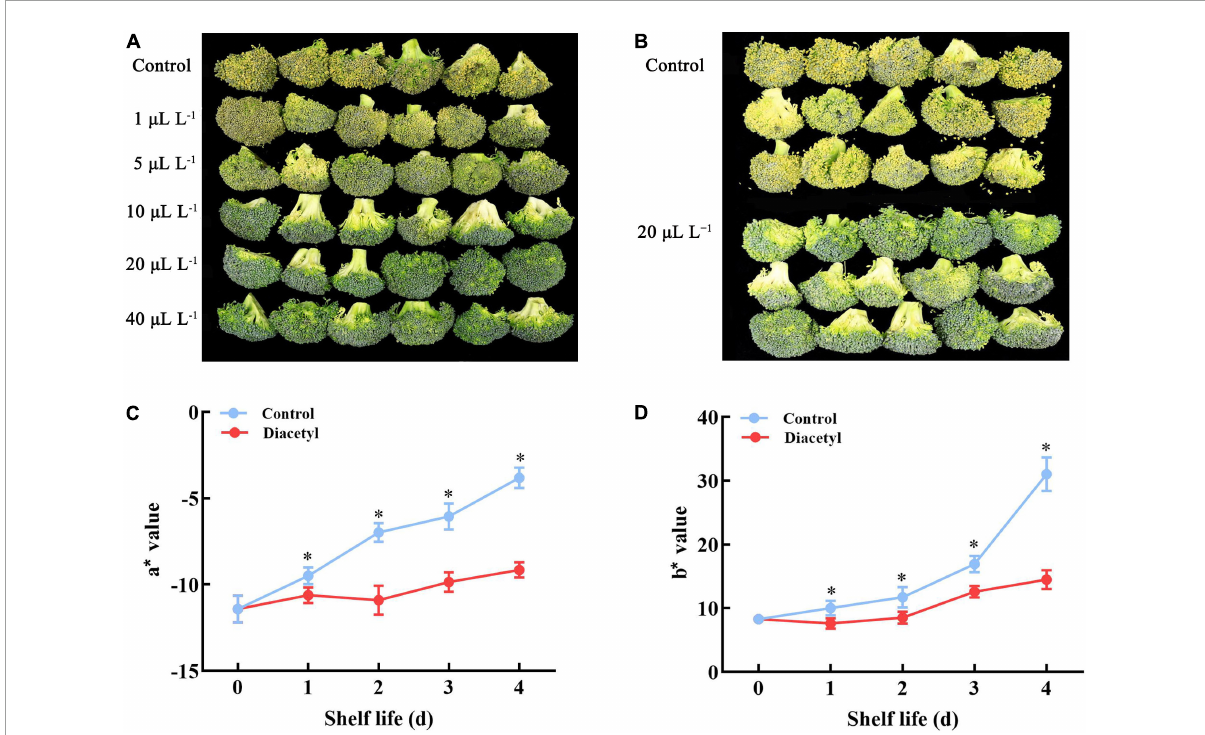
FIGURE1 Diacetyl delayed broccoli floret yellowing during shelf life. Appearance of broccoli florets treated with different concentrations of diacetyl (A) , appearance of broccoli florets treated with 20 µ l L − 1 diacetyl (B) , a ∗ (C) and b ∗ (D) values of broccoli florets treated with 20 µ l L − 1 diacetyl. Data are the average of three replicates ± SD. Asterisk ( ∗ ) indicates a significant difference among the control and diacetyl treatment groups at the same time at P <